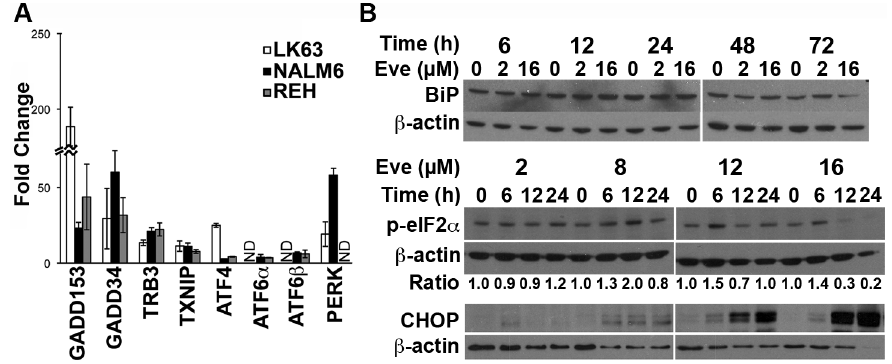
Figure 4. Everolimus Induces ER Stress. ( A ) NALM6 cells were treated with 16 m M everolimus overnight and qRT-PCR used to evaluate the expression of the indicated genes. The mean 6 SD of the fold change from 3 experiments is shown. ( B ) NALM6 cells were incubated with the indicated concentrations of everolimus for the specified time periods and cell lysates prepared. Sequential Western blotting was performed on the same membrane to determine the levels of the indicated proteins in each series of panels. Phospho-eIF2 a bands were quantitated by densitometry and normalized to b -actin. doi:10.1371/journal.pone.0102494.g004 PLOS ONE |